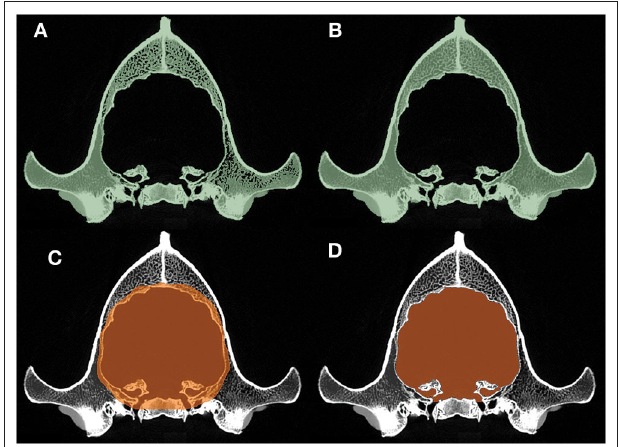
FIGURE 3 | Main phases of the segmentation process. (A) Automatic threshold-segmentation of the skull. (B) Complete segmentation of the skull after filling the remaining intraosseous parts. (C) Highlighting the raw endocranial volume together with its neighboring osseous structures. (D) The final shape of the endocast after subtracting the skull segment (B) from the raw endocranial segment (C) .